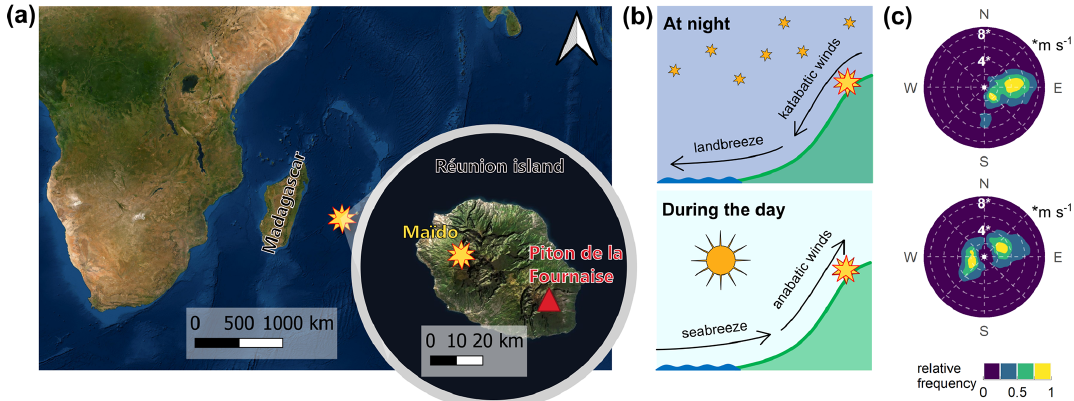
Figure 1. Site overview. (a) The location of Réunion Island in the tropical Indian Ocean and the location of Maïdo observatory (star) on Réunion Island (zoomed-in image). The rugged orography of the island was represented by overlaying a digital elevation model (Jarvis et al., 2008) over an aerial image (obtained from ESRI). (b) Schema of simplified mesoscale circulation patterns affecting Maïdo (star), characterized by katabatic winds and mostly lower free tropospheric influences during the night (top) and by anabatic winds and boundary layer influences during the day (bottom). (c) Wind speed and wind direction at Maïdo (observations from July 2017 to July 2018) show important day–night differences (compare to b ), with mostly fast easterly katabatic winds during nighttime (top) and a competition between easterlies and westerlies during daytime (bottom). The radial axis gives the wind speed (see dashed circles). The numbers give wind speed (ms − 1 ). The color scale is normalized, so that “1” corresponds to the most frequent combination of wind direction and wind